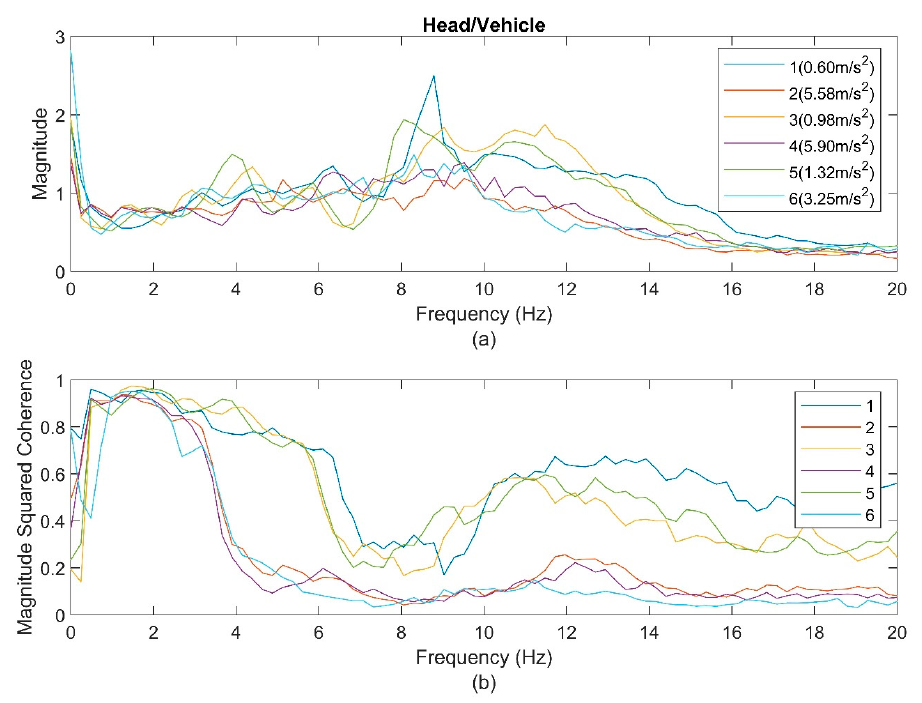
Figure 2. ( a )The transmissibility of the vertical acceleration of the head relative to the vehicle floor for Sections 1–6; the corresponding RMS values of the vertical acceleration for each section are provided in parentheses beside the legends, and ( b ) the corresponding squared coherence graphs.